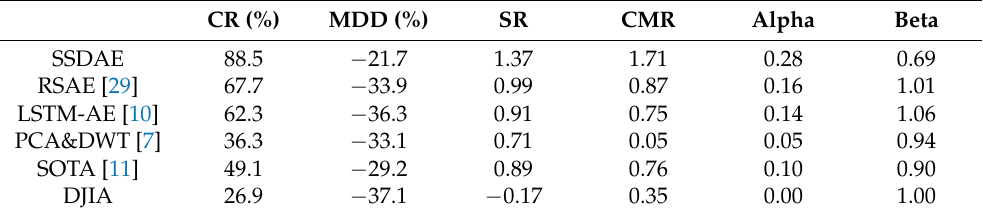
Figure 3. The cumulative wealth on DJIA. Table 5. The results in different RL methods.